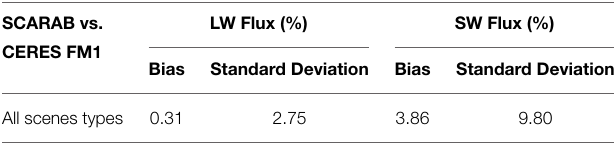
indicates for each layer, the median (central vertical line) and the lower and upper quartiles (left and right edges of the box). The whiskers indicate the lower and upper limits of the distribution within 1.5 times the interquartile range from the lower and upper quartiles, respectively. From Sivira et al. (2015) .